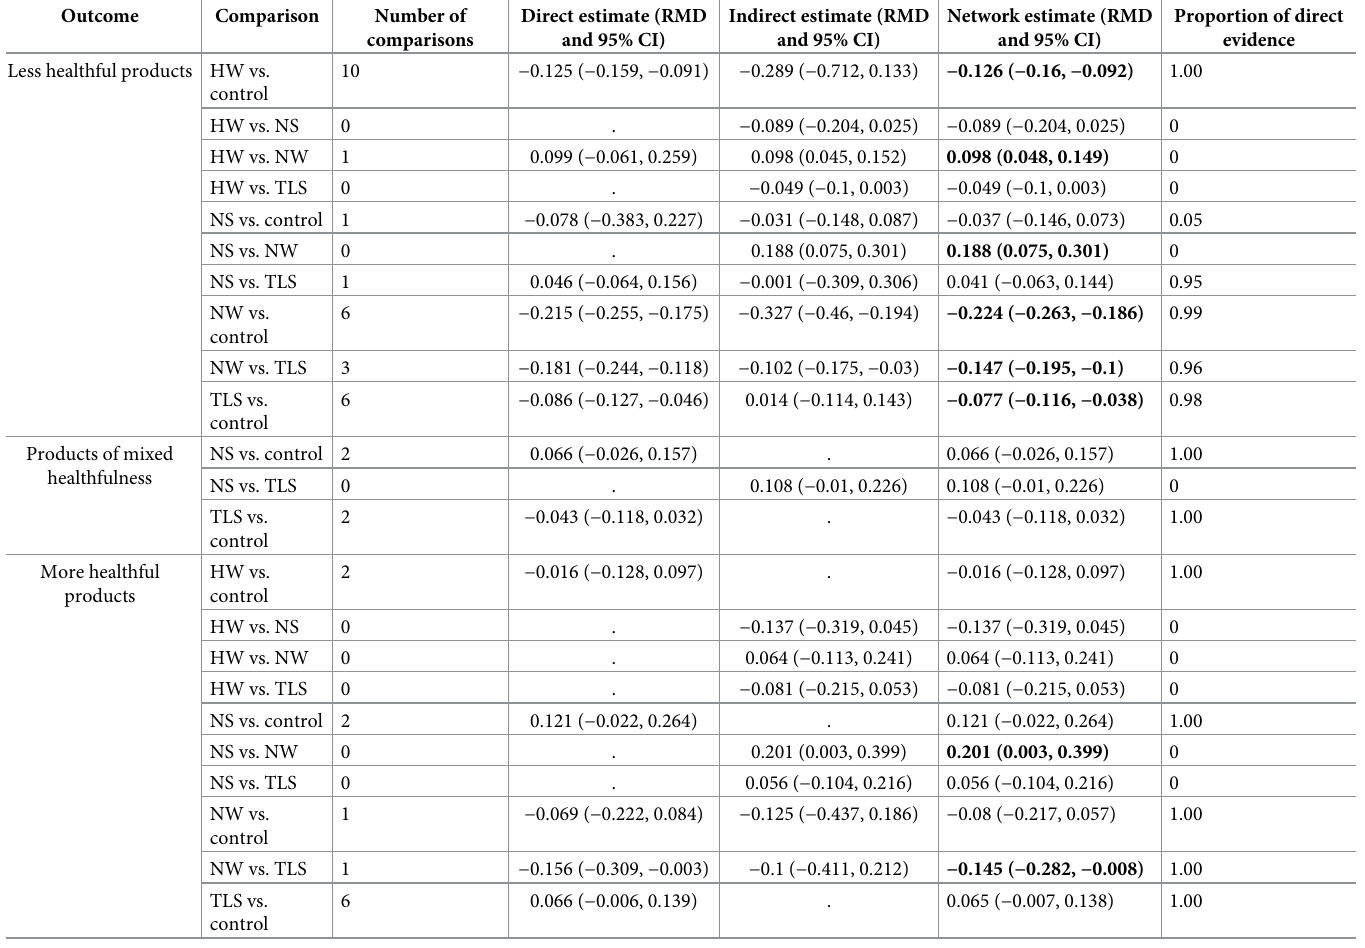
Table 4. The network effects of different label types on the perceived healthfulness of